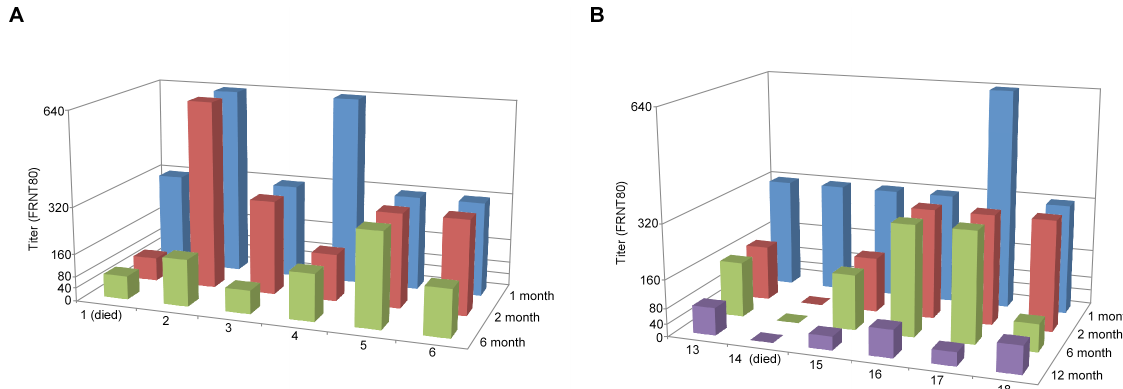
Figure 2. Neutralizing antibodies to ANDV are induced upon vaccination with VSV ∆ G- ANDV-glycoprotein complex (GPC). Sera were collected from animals at the time points indicated on the z -axis and used for an ANDV focus reduction neutralization test 80% (FRNT ) as described in the Experimental Section. ( A ) Animals 1–6 were challenged 6 80 months after vaccination and ( B ) animals 13–18 were challenged with ANDV 12 months post-vaccination and are indicated on the x -axis. Animals 1 and 14 developed disease upon ANDV challenge and were